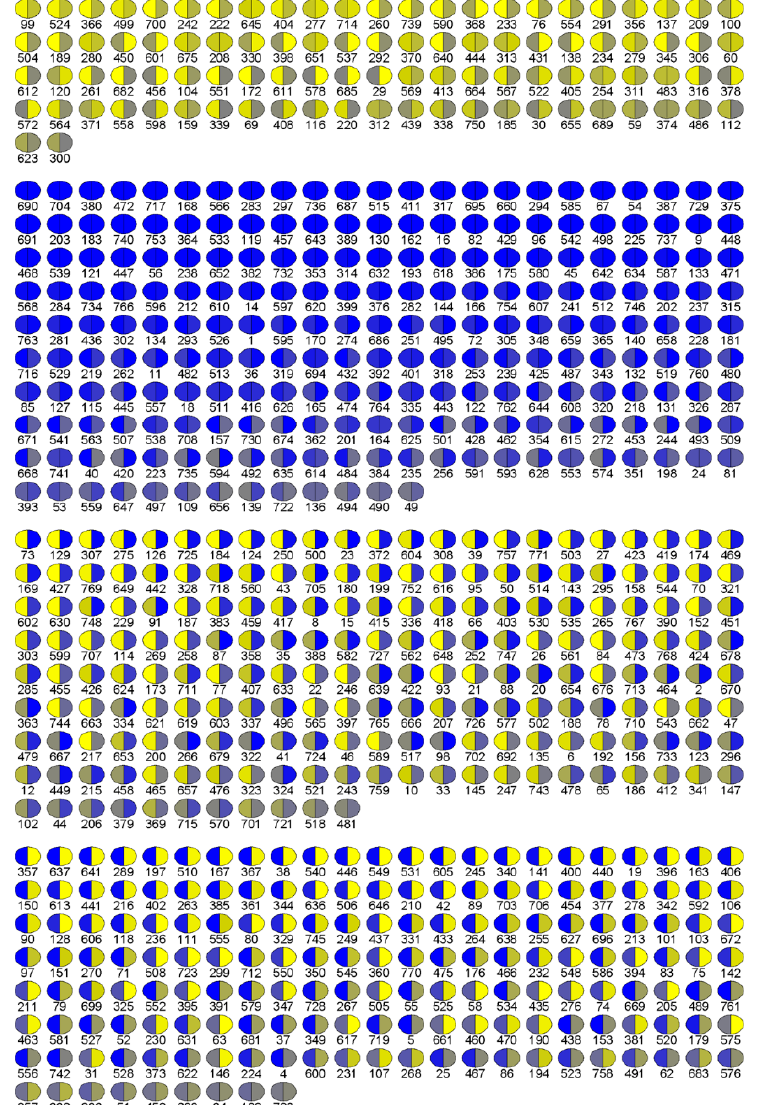
Figure 4. Peptide Phosphorylation Differentially Affected by Treatment with Postbiotic or C. perfringens Challenge. Each spot represents a peptide on the array which corresponds to a kinase recognition site. Each number represents a peptide, and the identities of each peptide can be found in Supplementary Table 1. The left half of each spot shows the differential phosphorylation status relative to control birds for postbiotic treatment in the jejunum. The right side of each spot shows the phosphorylation status relative to control birds for C. perfringens challenge in the jejunum. 3.4. Postbiotic and C. perfringens Uniquely Impact the Immune System While the Combination Shows Less